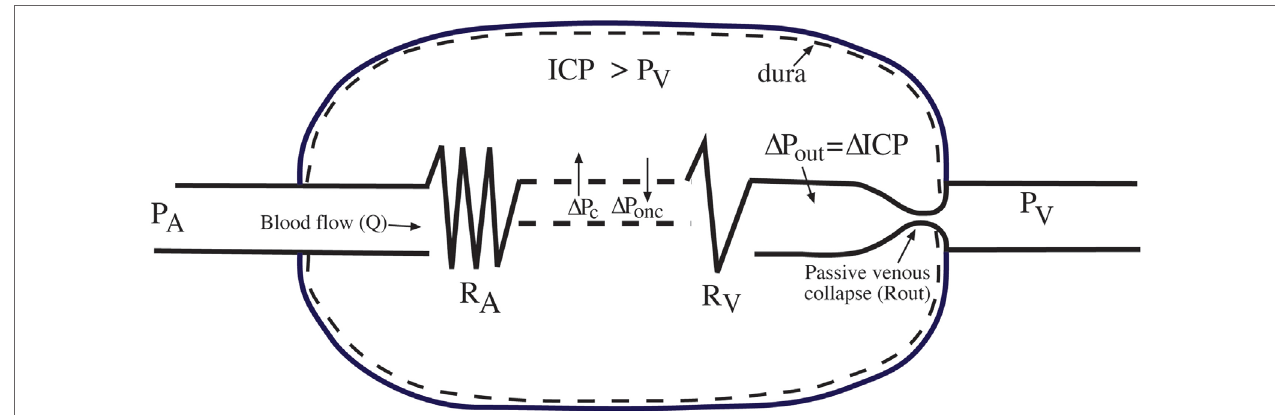
FiGURe 2 | Hemodynamic consequences for the brain enclosed in the rigid dura/cranium. Δ P c, transcapillary hydrostatic capillary pressure; Δ P onc , transcapillary oncotic pressure; P A , the arterial inflow pressure; Q, cerebral blood flow; R A , arterial precapillary resistance; R V , venular resistance; Δ P out , transvascular pressure retrogradely to the subdural venous collapse ( R out ); P V , is extracranial venous pressure. For details, see text. Reproduced from Ref. (3), with